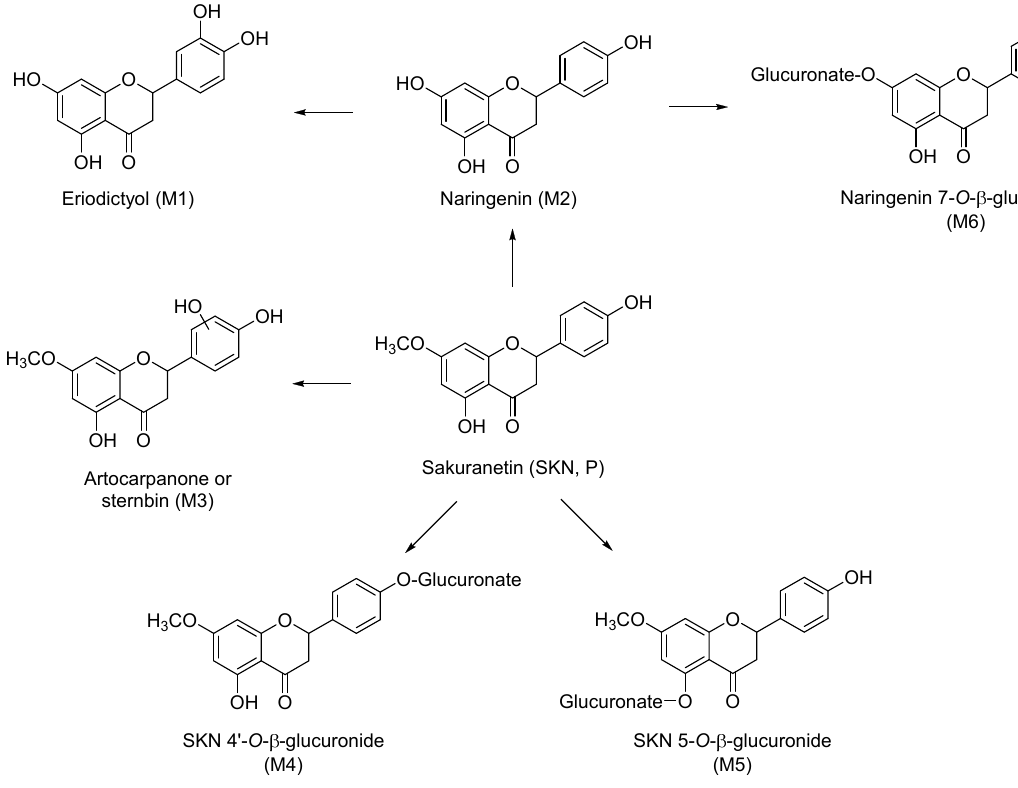
Figure 3. Proposed scheme for the phase I and phase II metabolic pathways of SKN in human liver microsomes. SKN is O -demethylated to naringenin (M2), which is then further oxidized to eriodictyol (M1) via flavanone B-ring oxidation. SKN is also oxidized to either artocarpanone or sternbin (M3) by the same type of oxidation. Both SKN and naringenin are subjected to glucuronide conjugation (M4, M5, and M6) by UGT. Table 4. Cytochrome P450 (CYP) inhibition effects of SKN in human liver microsomes.